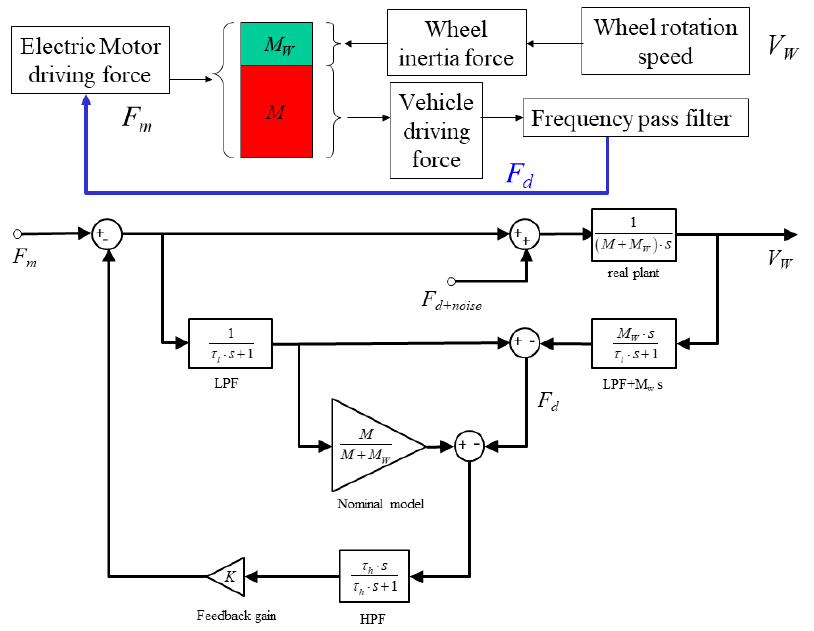
Figure 3. Design of tire disturbance controller for mechanical tire noise cancellation (LPF: low pass filter, HPF: high pass filter).